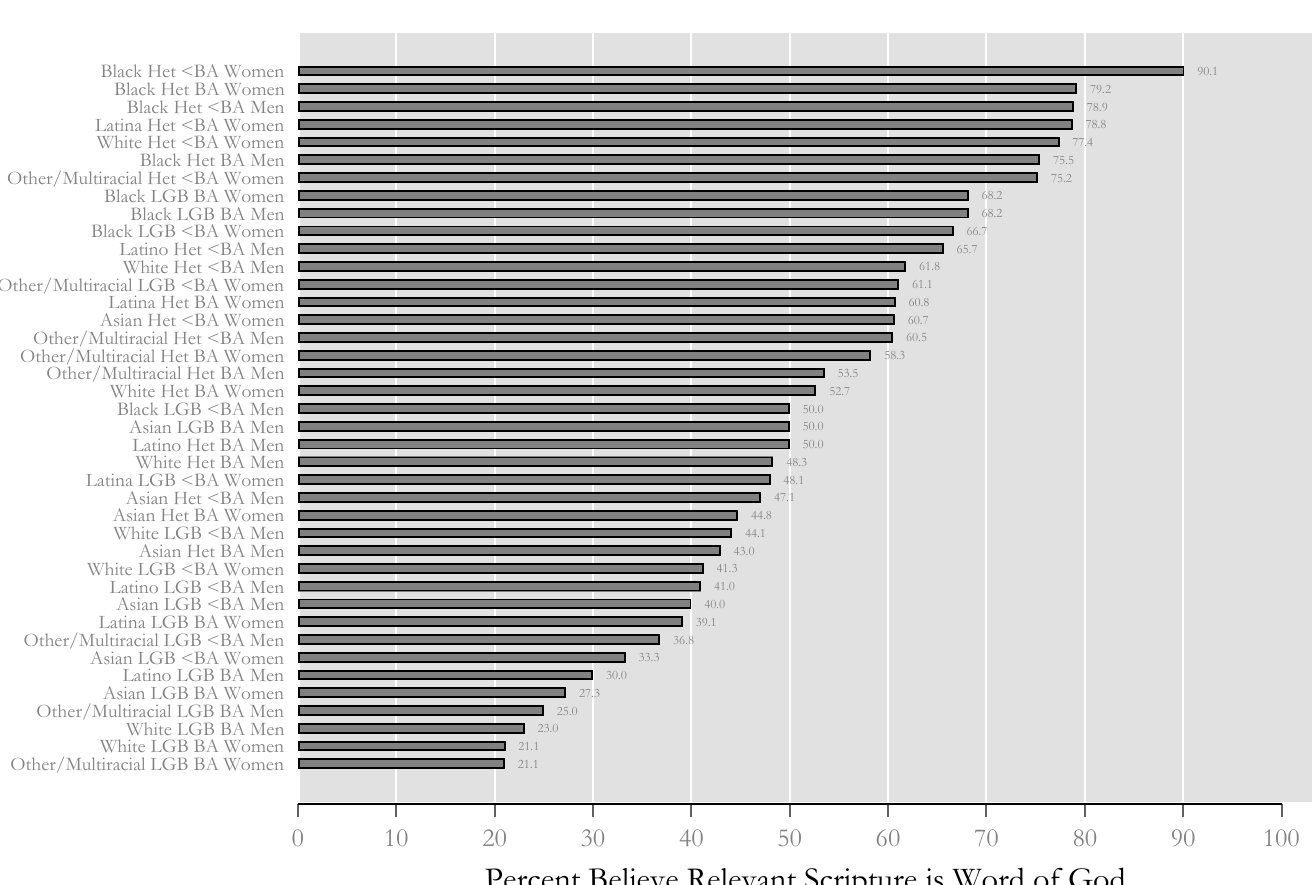
Figure 8. Belief in scripture as word of God across configurations of status characteristics, RLS (N = 31,089).